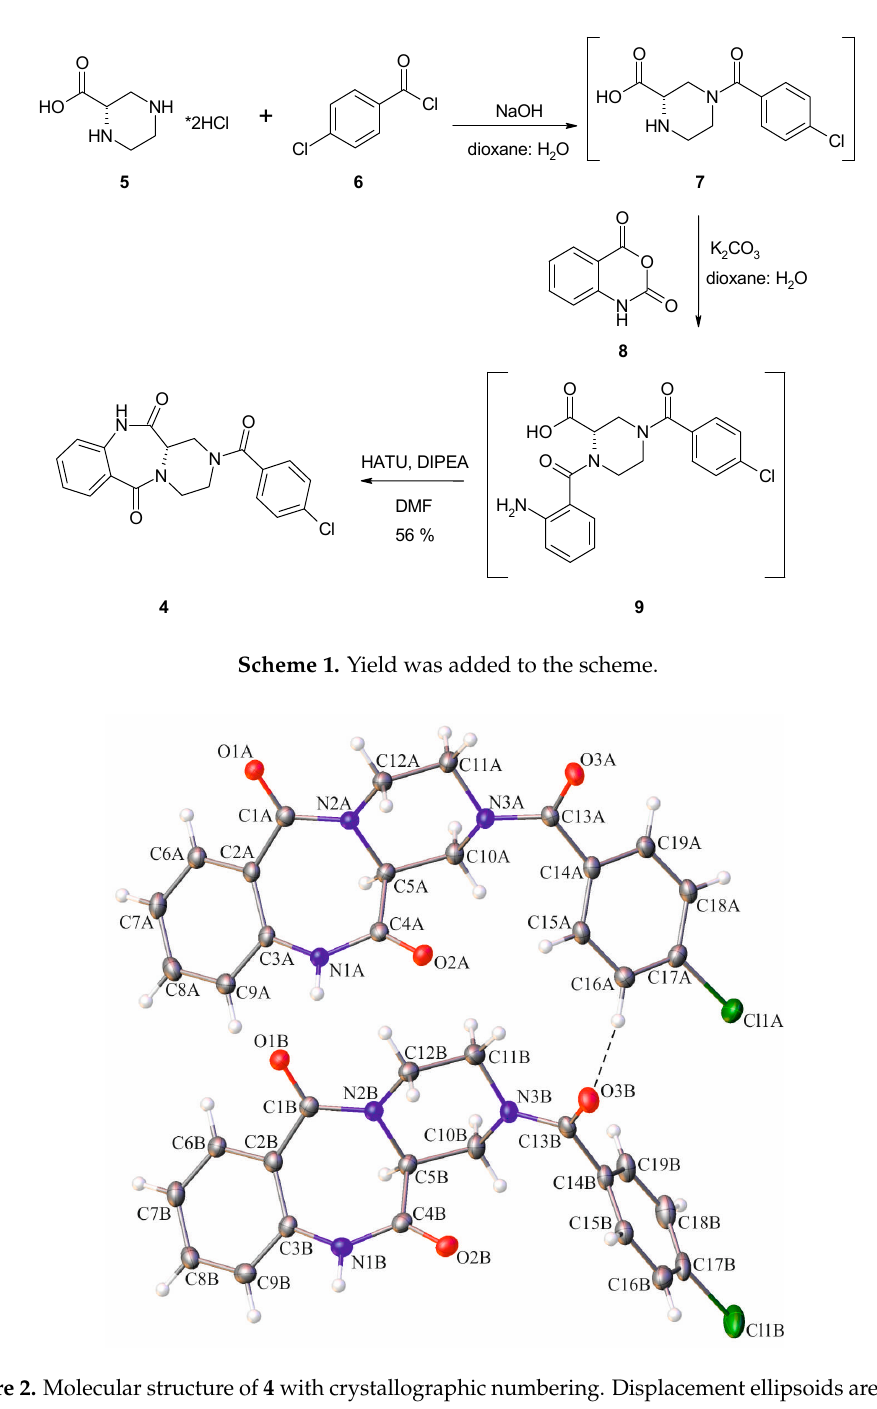
conformations, respectively. On the other hand, a noticeable difference is observed comparing the spatial orientation of the 4-chlorobenzoyl substituent. Values of the dihedral angle between the mean-quadratic planes delineated by the carbon atoms of the phenyl rings of the 4-chlorobenzoyl and the 1,2,3,4-tetrahydrobenzo[ e ]pyrazino[1,2- a ][1,4]diazepine-6,12(11 H ,12 aH )-dione moieties are 64.5(2) ◦ and 85.7(2) ◦ in A and B, respectively.